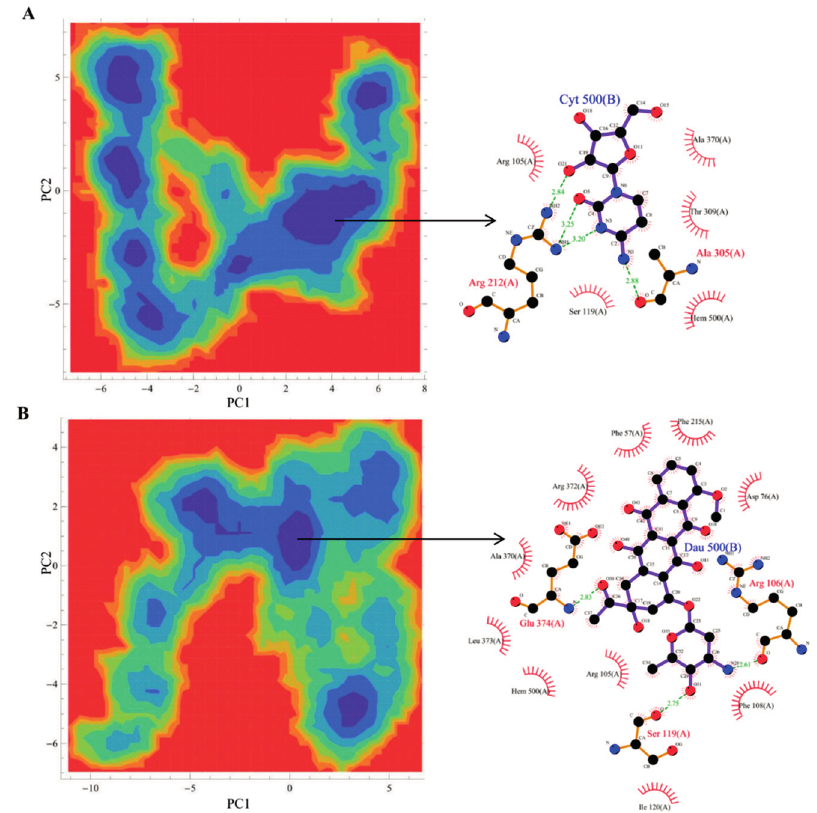
Figure 4. Free energy landscape (FEL) and the representative lowest energy conformation of simulated drugs. The FEL of the simulated complexes based on the principal component analysis: ( A ) cytarabine; ( B ) daunorubicin. Each representative structure is displayed from the most populated free energy minimum clusters using